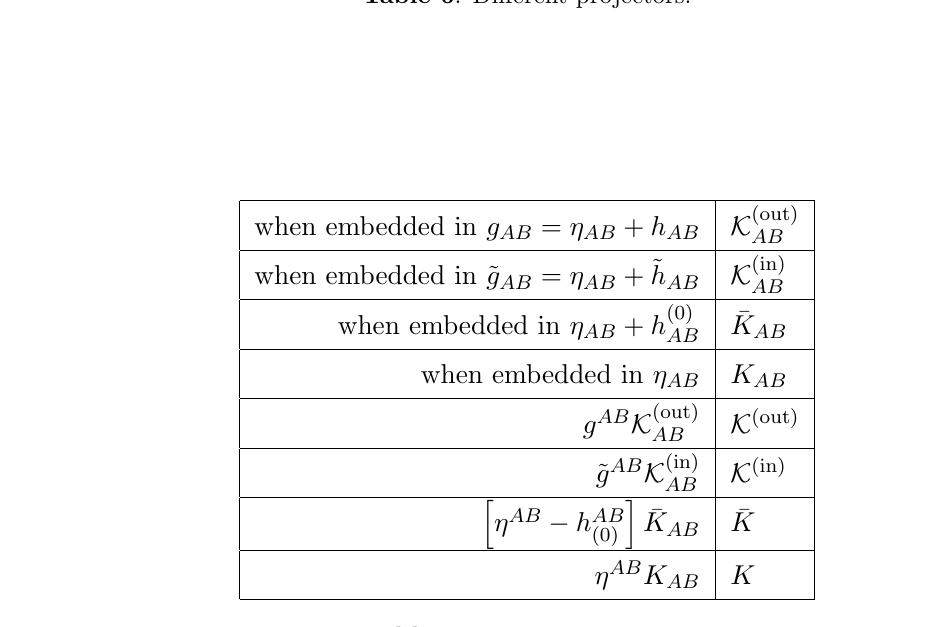
Table 7 . Extrinsic